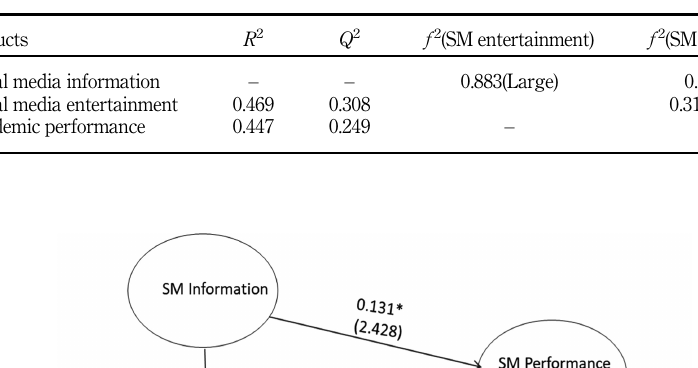
Figure 1. Structural path results presenting the link between SM information, entertainment and academic performance